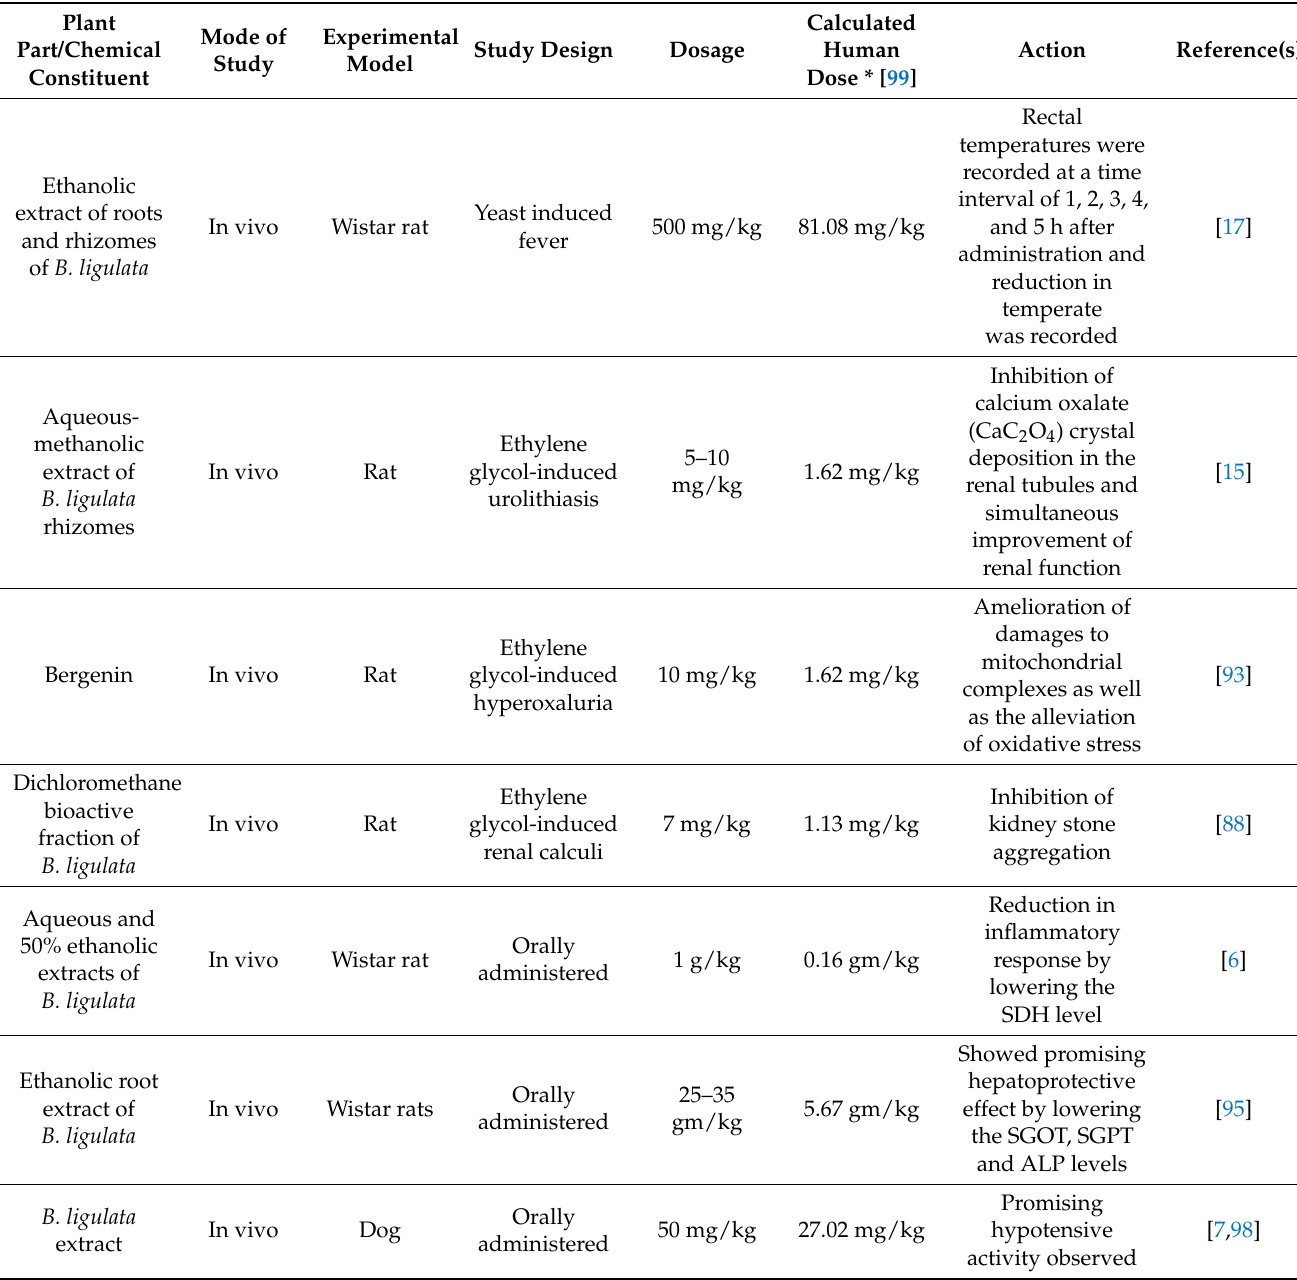
Table 2. Clinical significance of Bergenia ligulata in various experimental models, and their key findings along with calculated human